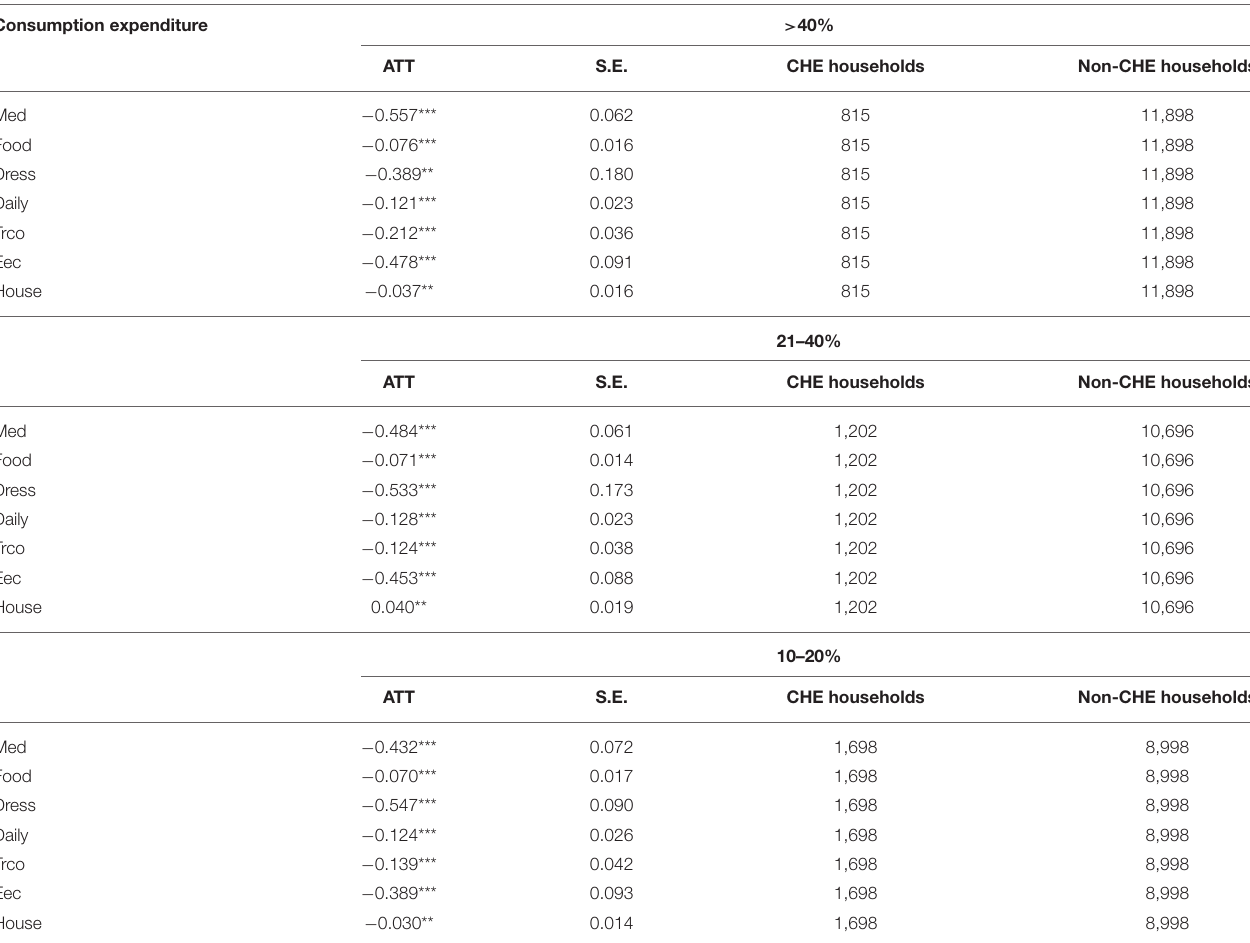
TABLE 6 | The average treatment effect (ATT) of CHEs for various household consumption expenditures. Consumption